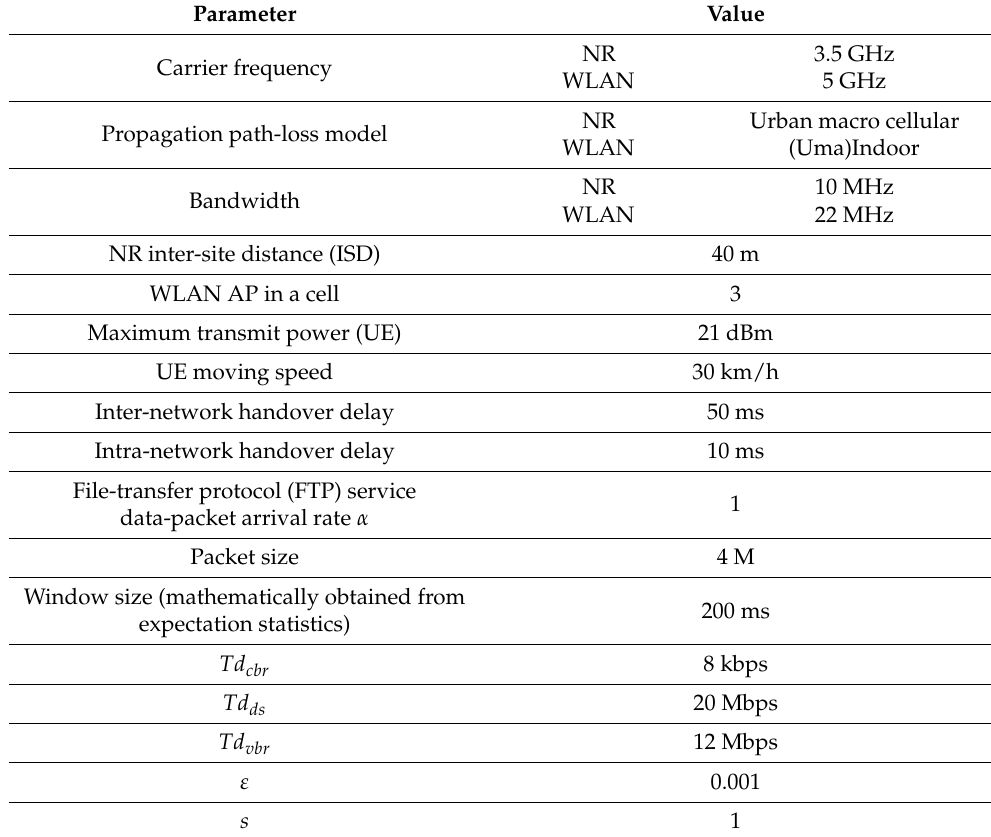
Table 1. Simulation parameters and corresponding